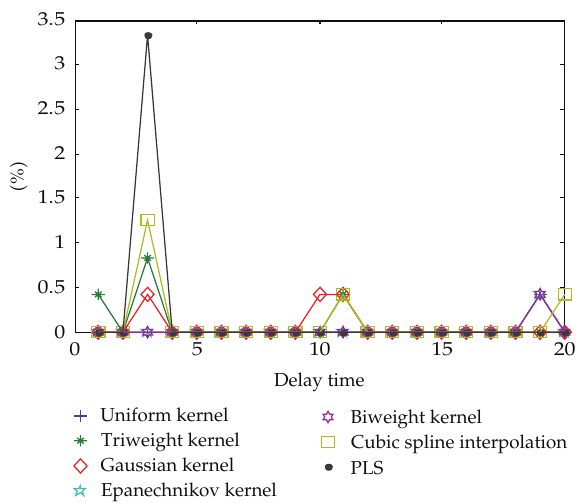
Figure 5: Delay time analysis of some forecasting method.